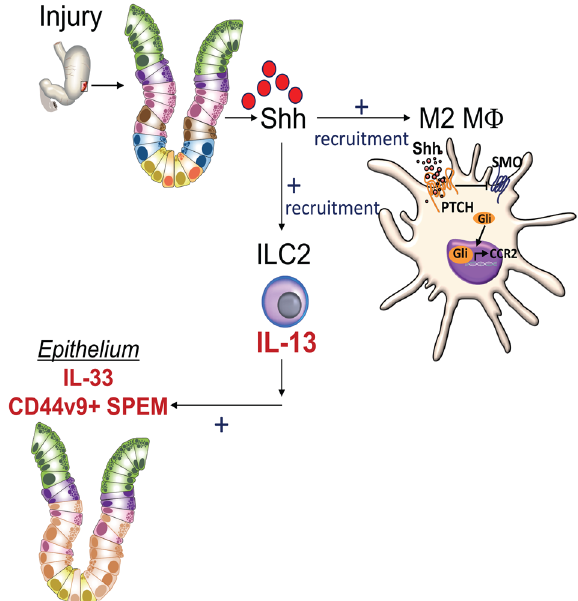
Fig. 10 Schematic diagram showing the role of Shh as a macrophage chemoattractant during regeneration of the gastric epithelium. Shh, secreted from the gastric parietal cells in response to acute injury to the stomach induced macrophage chemotaxis and subsequently CD44v9-expressing SPEM. Shh acts as a macrophage chemoattractant via a smoothened-dependent mechanism. IL-33 is released from the injured epithelium, and macrophages drive the polarization of macrophages to an M2 phenotype. IL-13, released from recruited ILC2 cells, subsequently regulates the development of CD44v9-expressing SPEM, which is crucial for the regeneration of the gastric